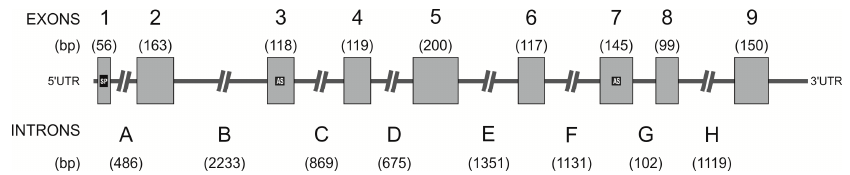
Figure 2. Structural organization of the hPAG-L/pep gene. Exons (1–9) are boxed with their sizes shown in parenthesis above each box. The introns (A–H) are represented as lines with their sizes shown below each. Exons 3 and 7, which contain the catalytic aspartic acids at the active site, are shaded. The untranslated regions are represented by lines labeled 5 ′ UTR and 3 ′ UTR. Abbreviations: SP—signal peptide; AS—active site sequences coding domains 1 and 2 of the catalytic cleft.